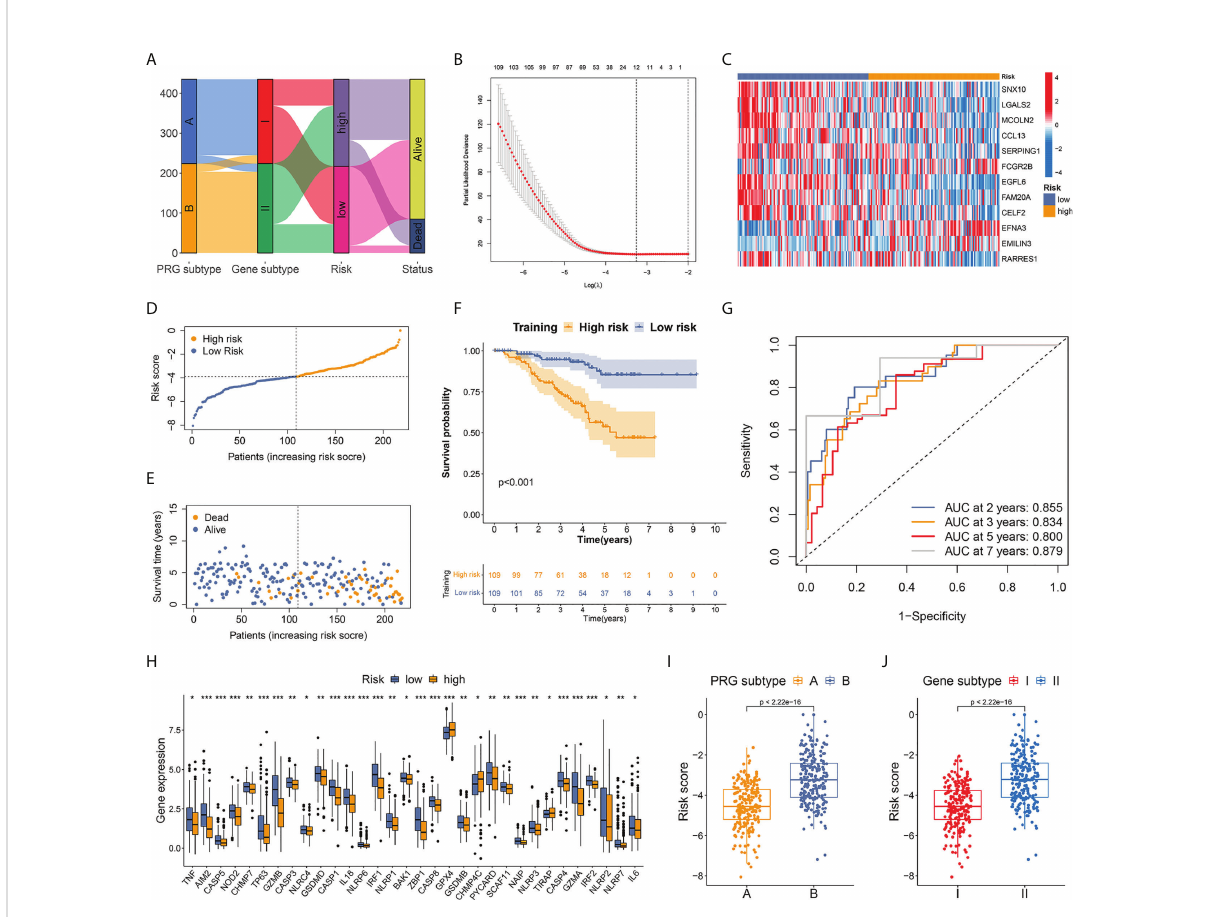
FIGURE 5 Establishment of a risk score based on pyroptosis-related prognostic DEGs. (A) Alluvial diagram of patients ’ distribution between different subtypes, risk groups, and vital status. (B) OS-related DEGs identi fi ed by univariate Cox analysis were screened by LASSO regression. (C) Expression heatmap of the 12 hub DEGs between two risk groups. (D) Risk score distribution in patients from training set. A median score of − 3.898 was de fi ned as the cutoff value. (E) Vital status plot showed higher death rate in patients from high-risk group in training set. (F) TNBC patients from high-risk group had markedly worse OS than low-risk patients. (G) AUC of ROC curves showed good performance of the 12-gene-based risk score in predicting 2-, 3-, 5-, and 7-year OS for patients in training set. (H) Differential expression of 32 PRGs between high- and low-risk groups. (I, J) Patients from both pyroptosis subtype A and gene subtype I, which represented activated anti-tumor immunity and better OS, had signi fi cantly lower risk score compared to subtype B and subtype II. * p < 0.05, ** p < 0.01, *** p <